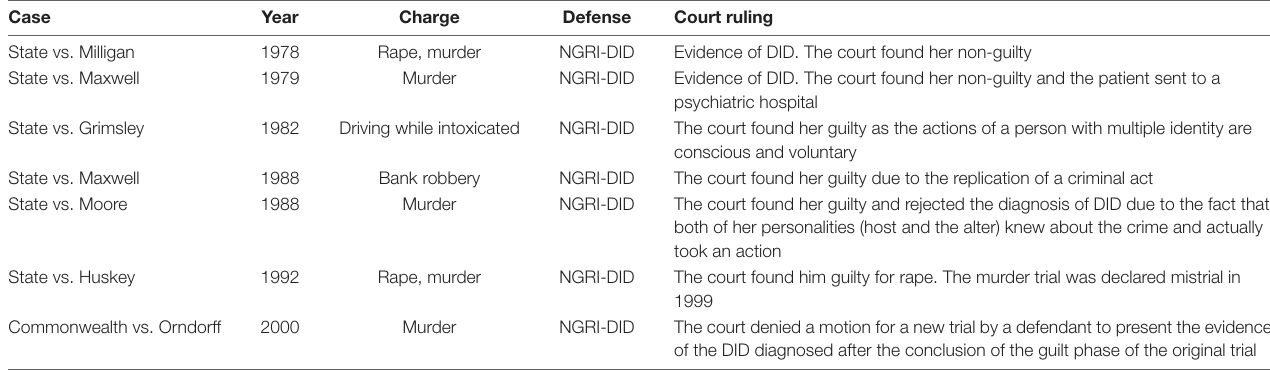
TABLE 1 | Court cases where DID was claimed as a basis for